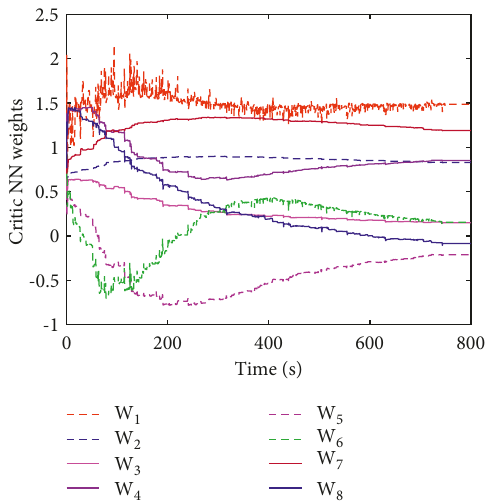
Figure 18: Tracking performance for _ q and _ q